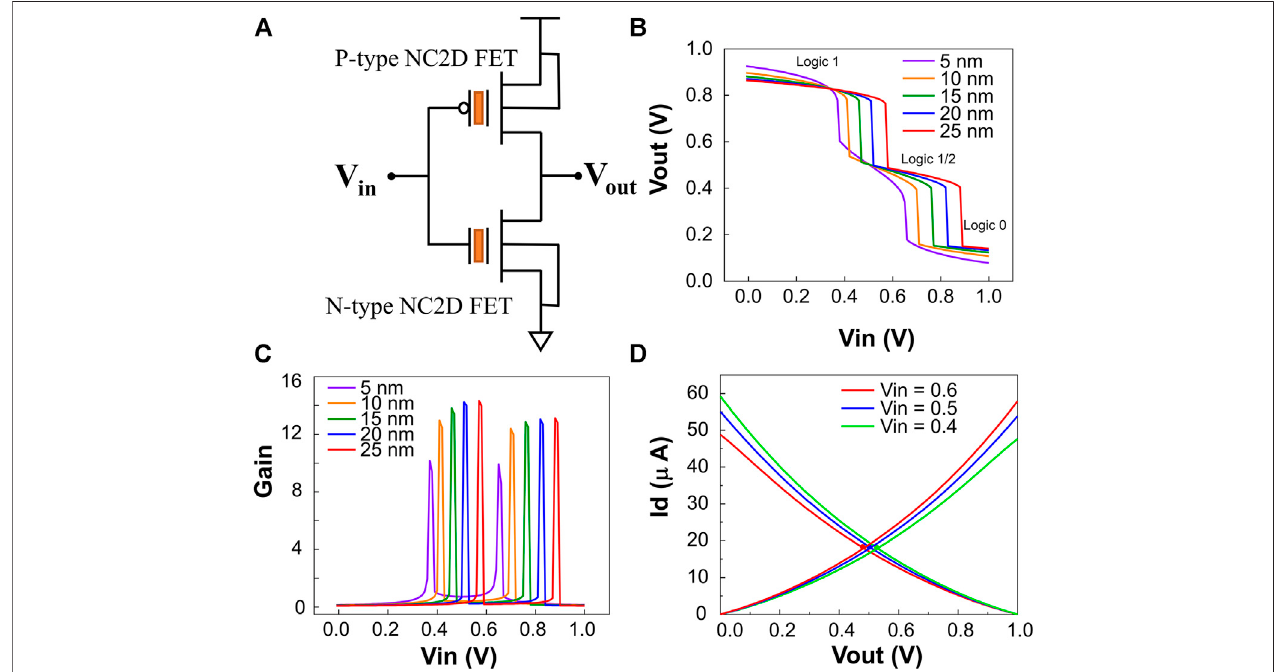
FIGURE 5 | Ultra-compact ternary inverter based on NC2D FETs. (A) Schematic representation of the simulated ultra-compact ternary inverter. (B) VTC of the ternary inverter with CIPS of different thicknesses. (C) DC gain of the ternary inverter. (D) . Load-line analysis of the ternary inverter.